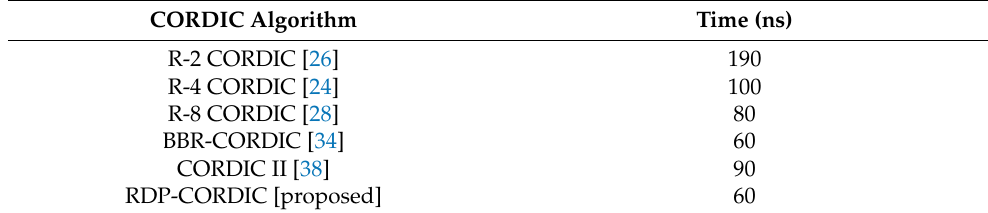
Table 7. Time consumed for the first calculation of the sine and cosine function.